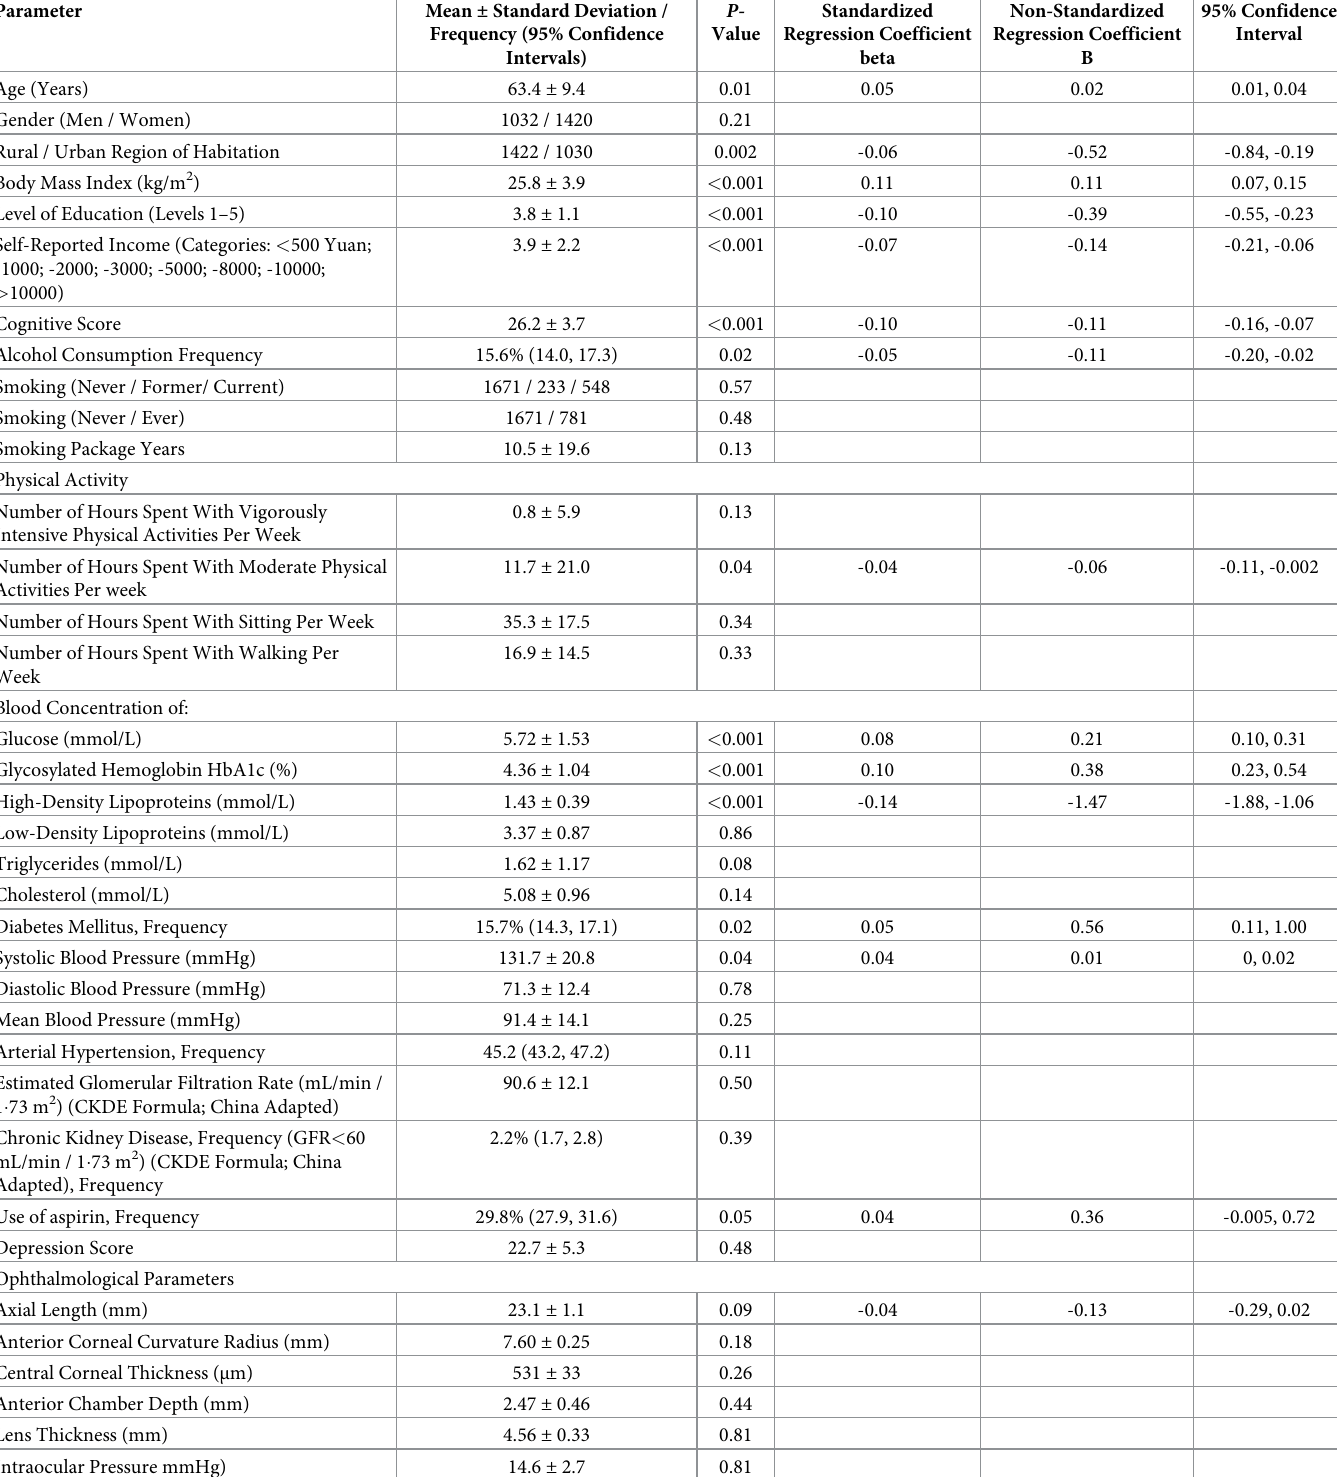
Table 1. Associations (univariate analysis) between the serum concentration of hs-C-reactive protein and other systemic and ocular parameters in the Beijing Eye